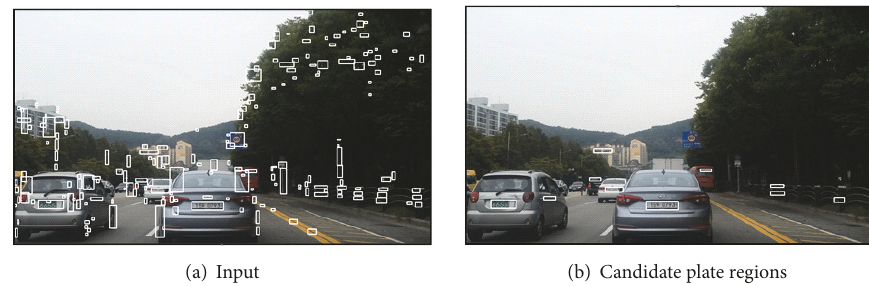
Figure 6: Candidate plate regions at the end of the first stage.